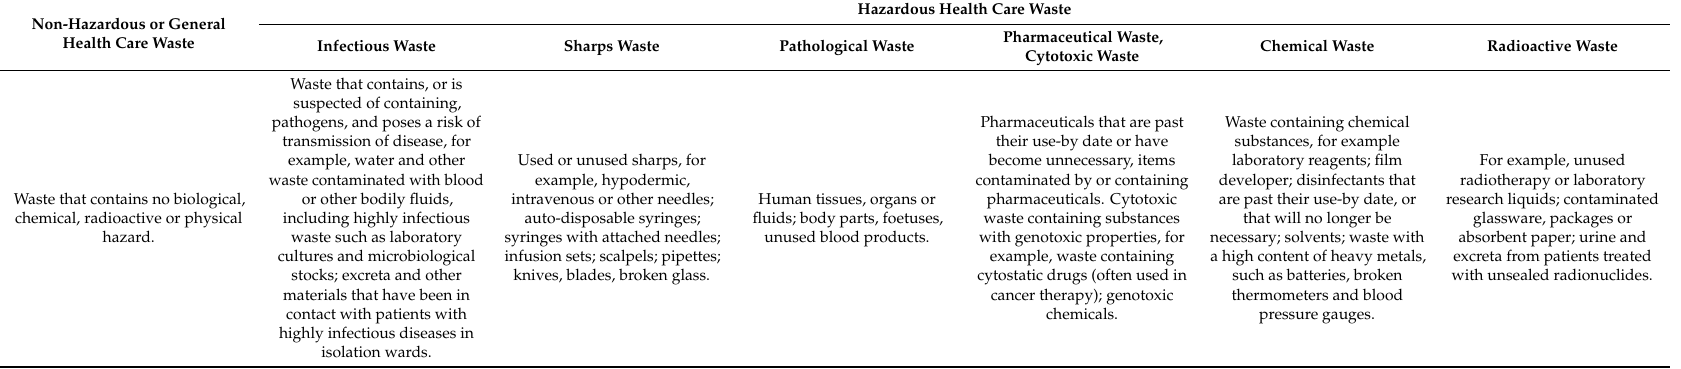
Table 1. Categories of health care waste